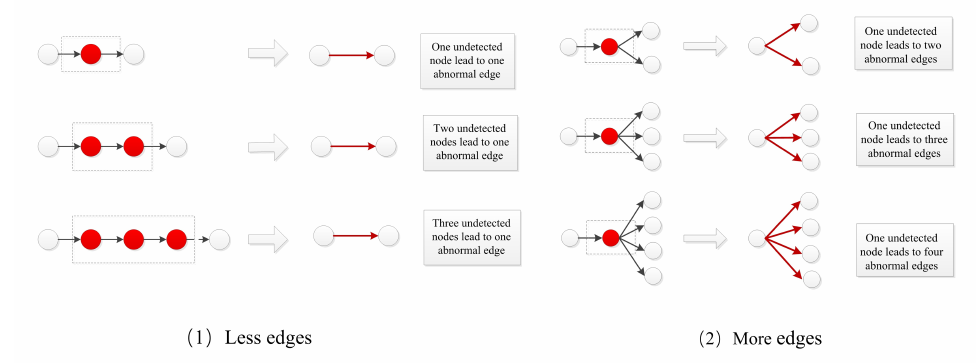
Figure 12. Two kinds of abnormal edges in real transmission